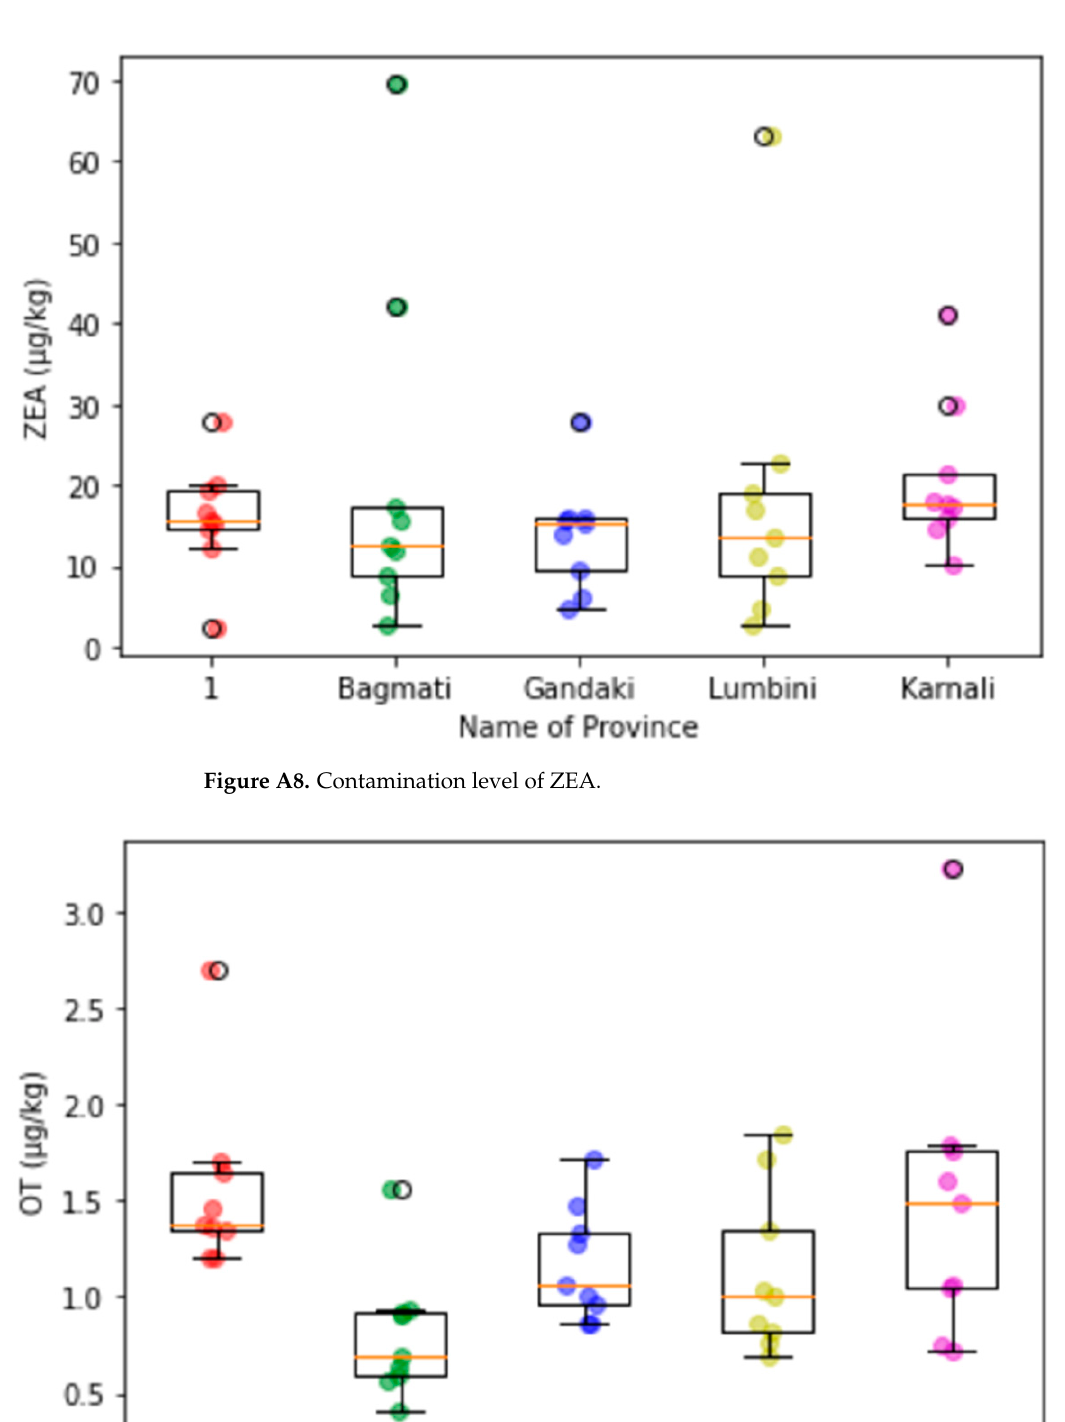
Figure A10. Contamination level of FUM.